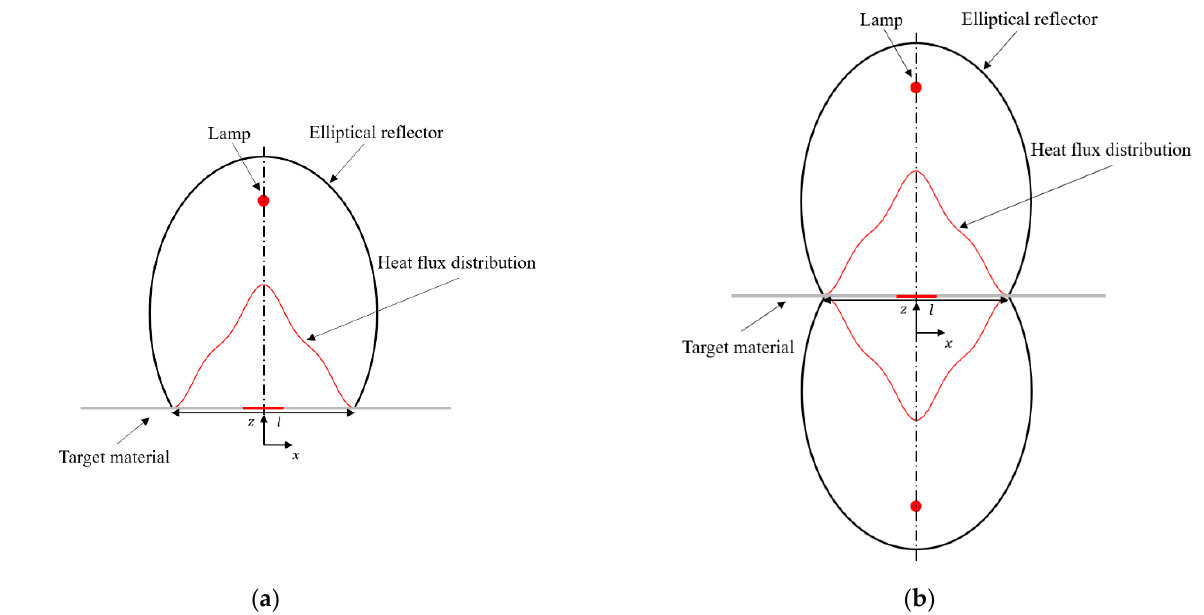
Figure 6. Illustration of two heating cases: ( a ) Single-surface heating; ( b ) Double-surface heating.